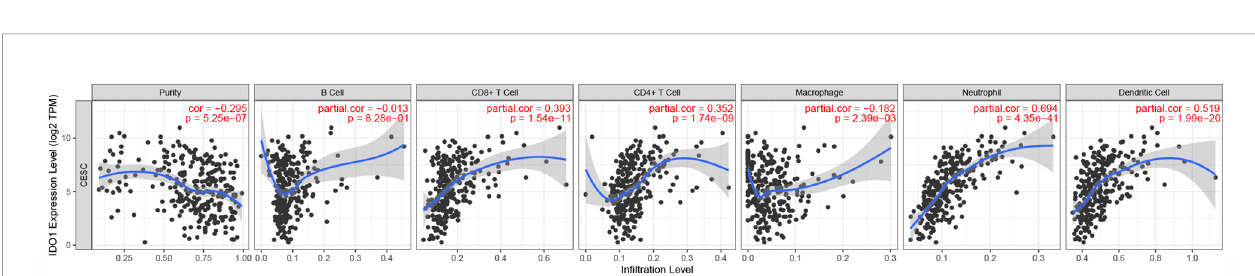
FIGURE 3 | Correlation between IDO1 expression level and the level of immune cell in fi